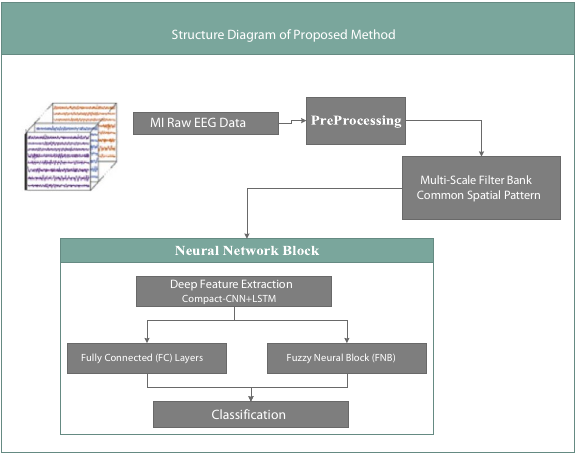
Figure 1. Schematic diagram of the proposed framework